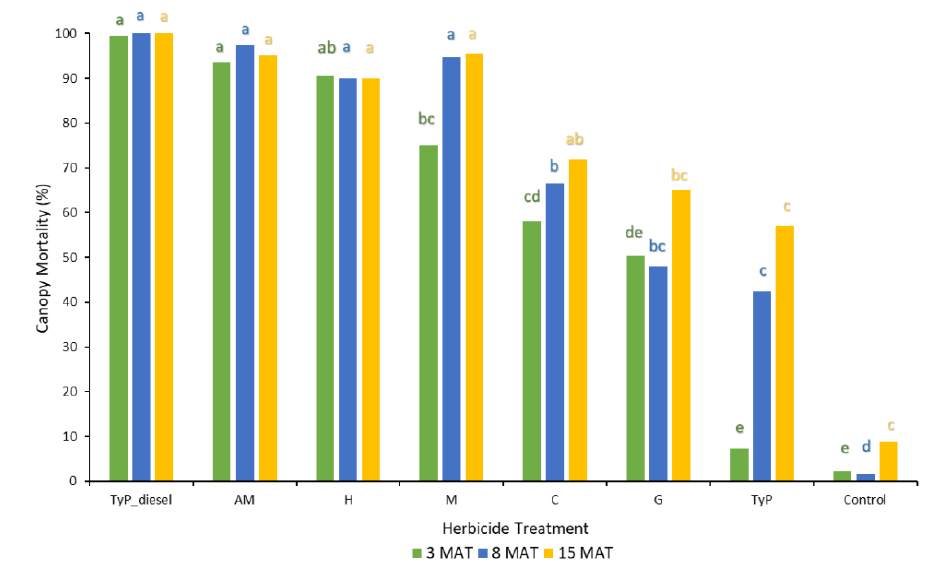
Figure 5. Mimosa bush canopy mortality 3, 8 and 15 MAT following herbicide applications to intact plants in trial 1. TyP_diesel, triclopyr + picloram mixed with diesel; AM, aminopyralid + metsulfu- ron-methyl; M, metsulfuron-methyl; H, hexazinone; C, clopyralid; G, glyphosate; TyP, triclopyr + picloram capsule Di-Bak TyP™. For each monitoring time, columns with different letters indicate significant difference by Tukey’s test with 95% confidence.